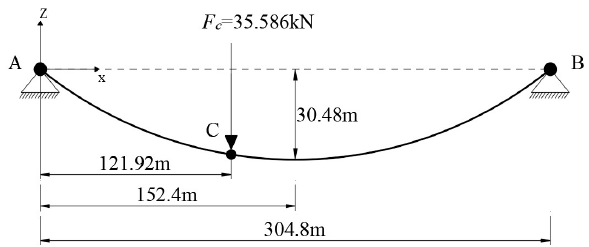
Figure 3. Calculation flow chart of subroutine UELxxx.